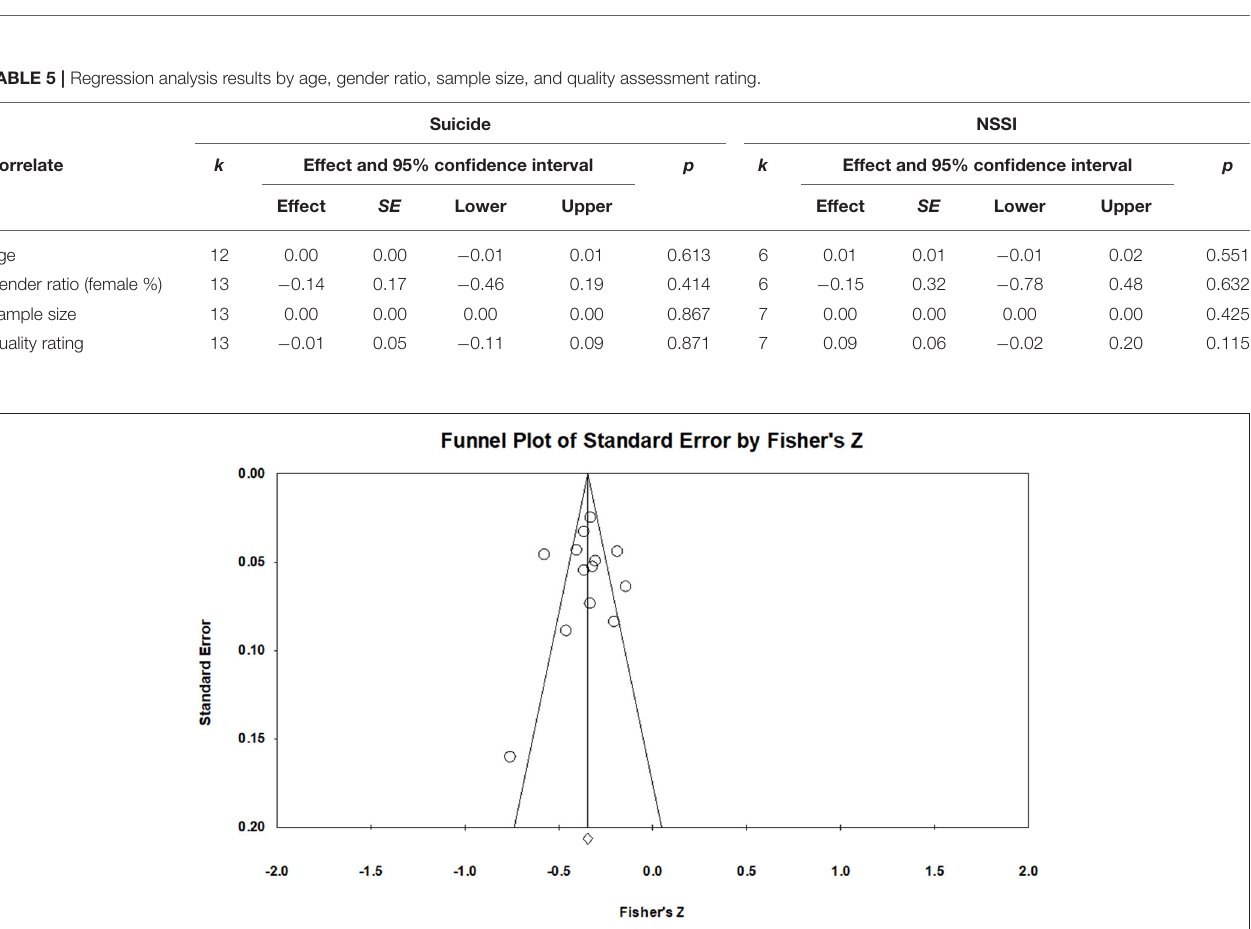
FIGURE 4 | Funnel plots of